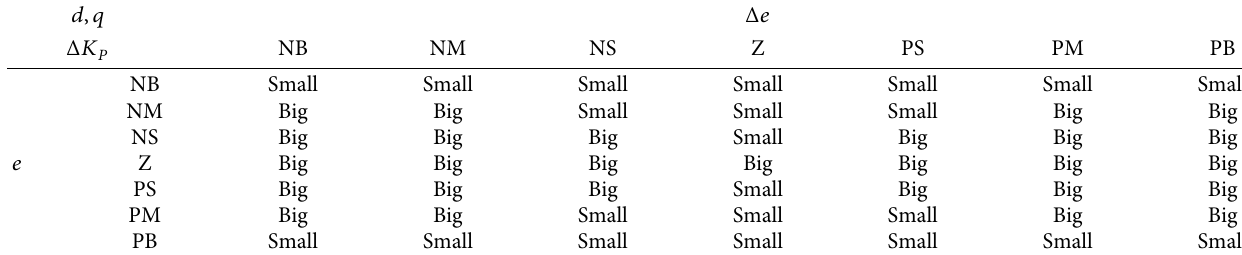
dq -axis. I output for